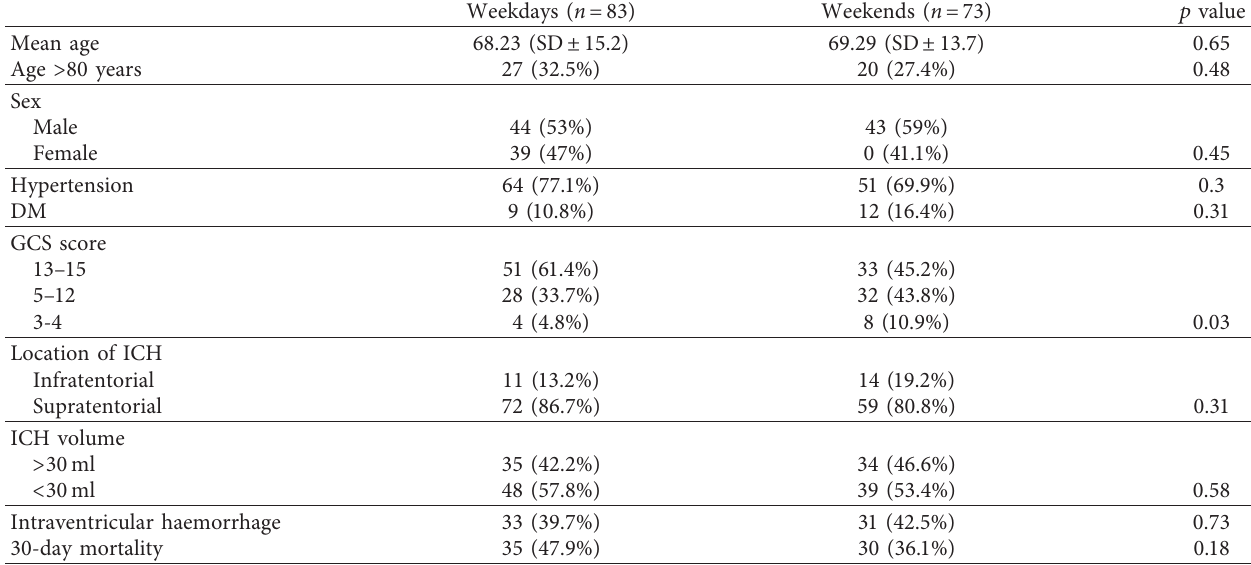
Table 3: Basic analysis of patient characteristics admitted on weekdays and off-hours.